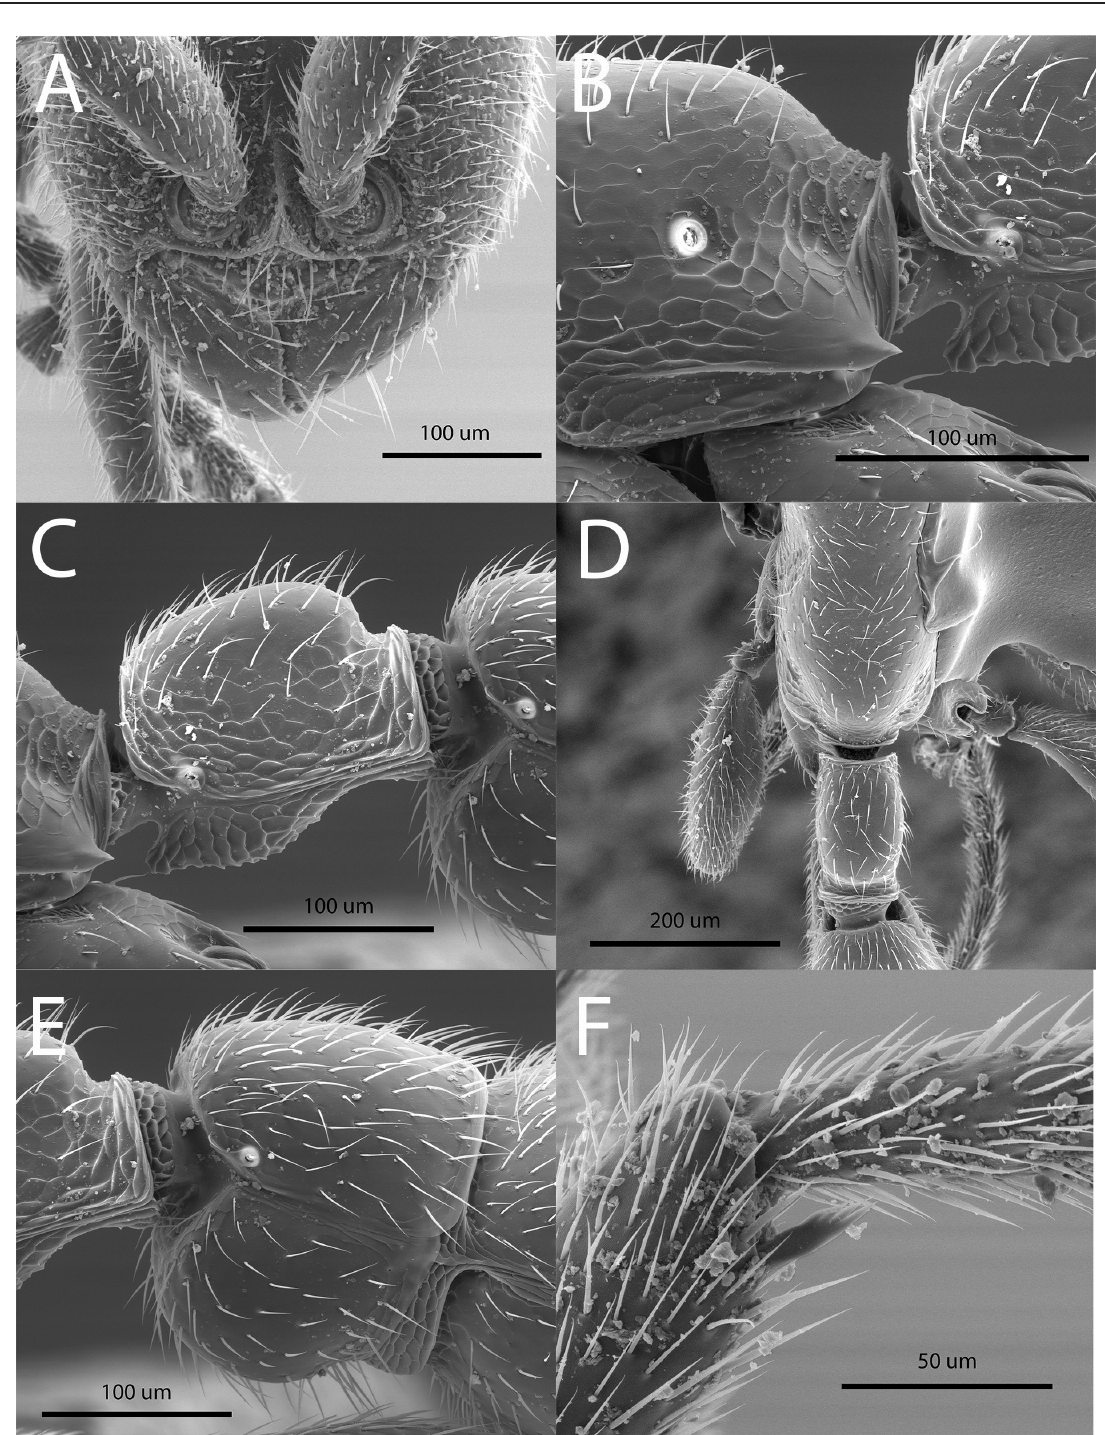
Fig. 3. Leptanilloides copalinga Delsinne & Donoso sp. nov. Paratype worker (specimen code 4006301). A . Anterior part of the head in full-face view, showing vertical and fused frontal carinae, exposed antennal socket, lateroclypeal tooth, strongly convex clypeal lamella and subtriangular mandible with minute denticles along its inner margin. B . Lower part of propodeum in lateral view, showing the long and sharp flange over the metapleural gland opening. C . Petiole in lateral view. D . Propodeum and petiole in dorsal view. E . Abdominal segment III (postpetiole) in lateral view. F . Mesotibial spur, short and